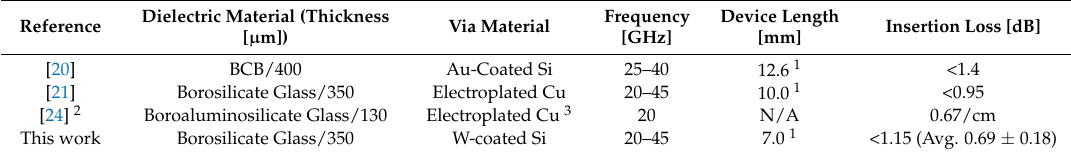
Table 2. Performances of the proposed substrate integrated waveguide (SIW) compared with other millimeter-wave